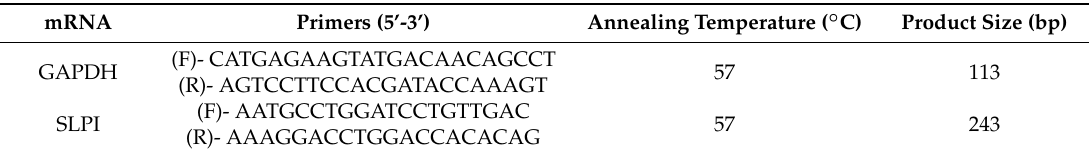
Table 1. Details of primer pairs used in analysis of mRNA expression by qRT-PCR. SLPI: secretory leucoprotease